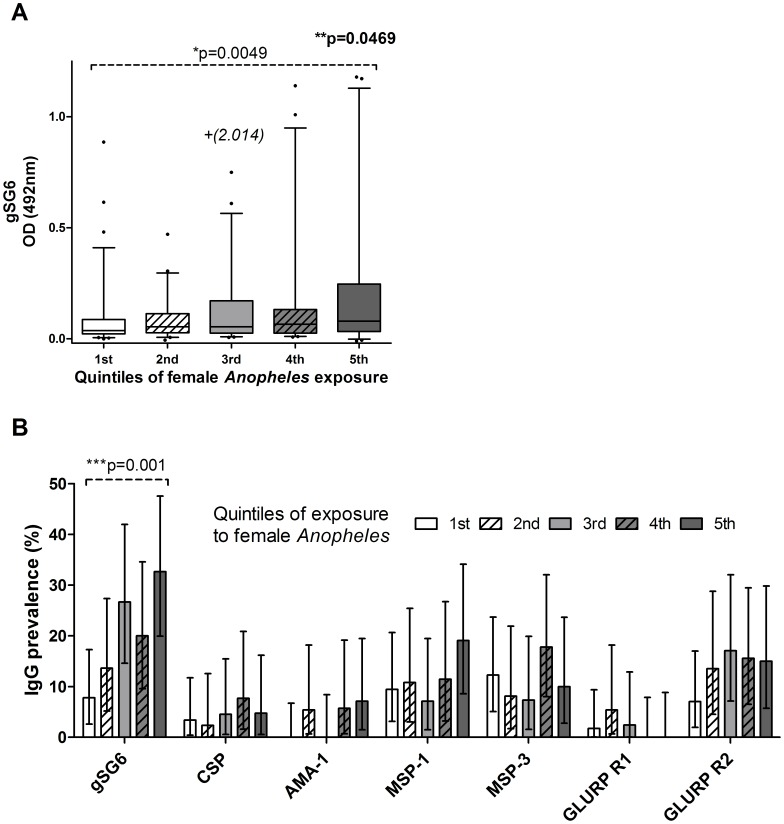
IgG responses to gSG6 and P. falciparum antigens, grouped into quintiles of household Anopheles exposure.
A. Box plots showing anti-gSG6 IgG level between groups sorted according to Anopheles exposure in quintiles. Boxes show the median and 25th/75th percentiles, whiskers show the 5th/95th percentiles, and outliers are represented by dots. Where outliers were excluded from the graph but not analysis they are marked with a + and included in parentheses. P values for pairwise comparisons were determined by Mann-Whitney test with Bonferroni correction (*), and for all groups by Kruskal-Wallis test (**). B. Seroprevalence of anti-gSG6 and anti-P. falciparum IgG antibodies plotted against Anopheles exposure in quintiles. Error bars indicate 95% confidence intervals (CI). P values were determined by a test for trend in proportions (***).